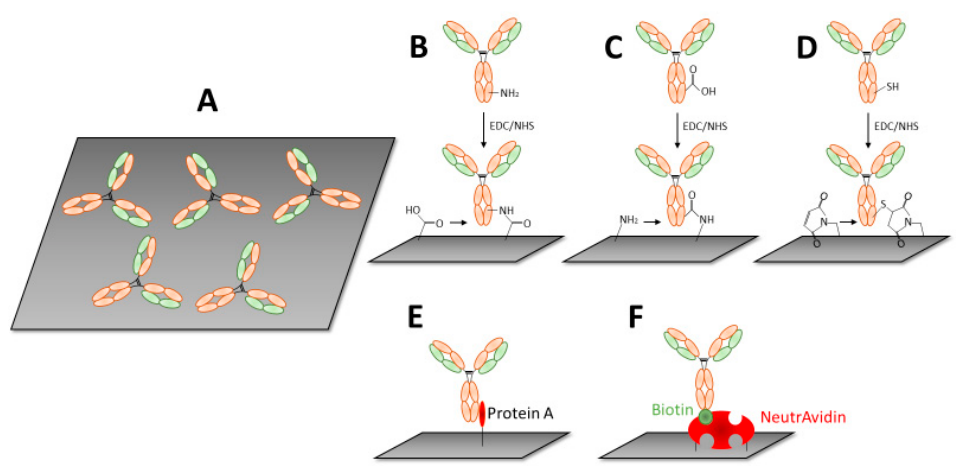
Figure 2. The scheme of the most frequently used methods of immobilization of antibodies at surfaces. ( A ) Physical adsorption; ( B ) covalent immobilization to 11-mercaptoundecanoic acid (MUA); cysteamine ( C ), or maleimide ( D ). ( E ) Protein A-Abs complexes; ( F ) biotinylated Abs immobilized at the surface of neutravidin monolayer. Partially adopted from Li and Chen 2018 [26].